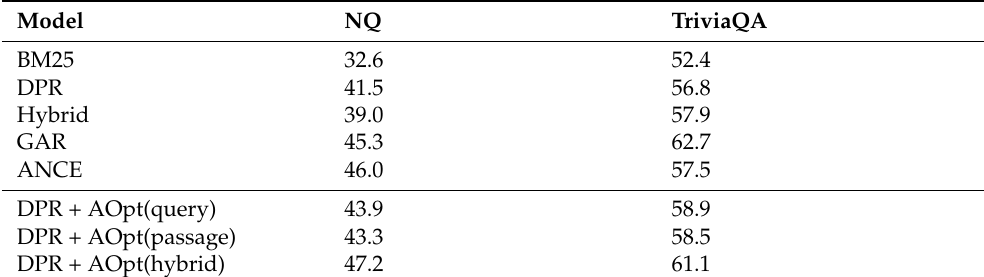
Table 4. QA Exact Match